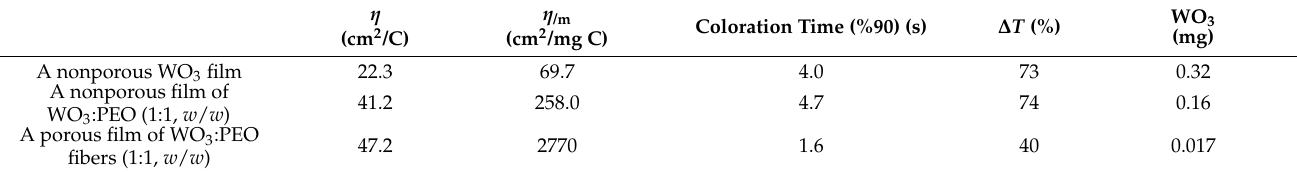
Figure 2. Scanning electron microscopy images of ( a ) a nonporous film of WO 3 ; ( b ) a nonporous film of WO 3 @PEO with WO 3 :PEO = 1:1; ( c ) a porous film of WO 3 @PEO with WO 3 :PEO = 1:1; ( d – g ) electrochromic characteristics of a nonporous film of WO 3 (black), a nonporous film of WO 3 @PEO with WO 3 :PEO = 1:1 (red), a porous film of WO 3 @PEO fibers with WO 3 :PEO = 1:1 (blue); ( d ) transmittance profiles at 700nm wavelength; ( e – g ) optical density of an ECD plotted against the charge density. The applied voltage was − 2 and 1 V in the colored and bleached states, respectively. Table 1. Electrochromic characteristics of WO 3 -based ECDs with different composites and morphol- ogies.